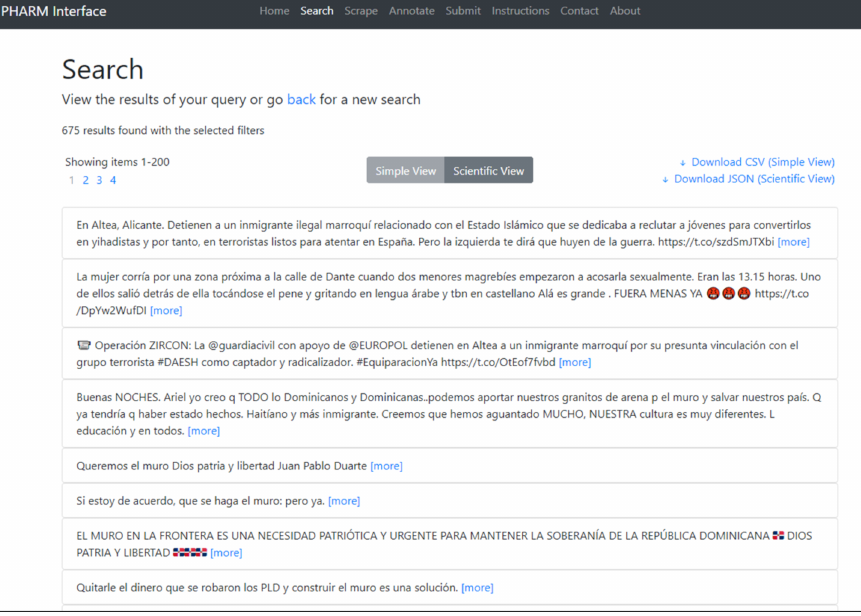
Figure 3. The search results screen of the PHARM Interface.